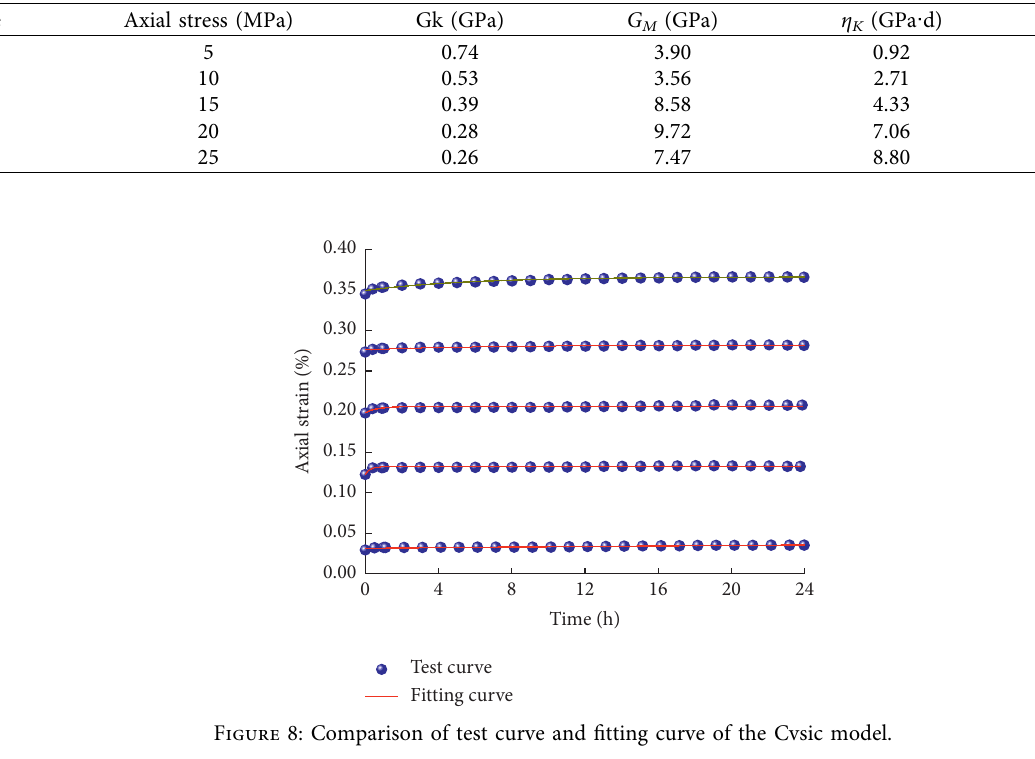
Table 1: Creep parameters of the Cvsic model.